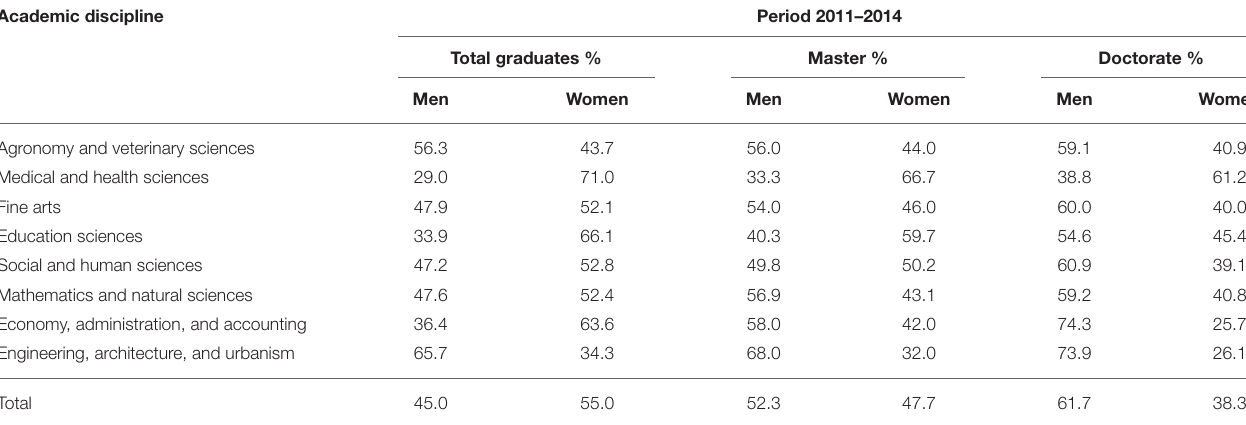
TABLE 2 | Percentage of total graduates from undergraduate and graduate programs at higher education institutions in Colombia, divided by gender and academic discipline for the time